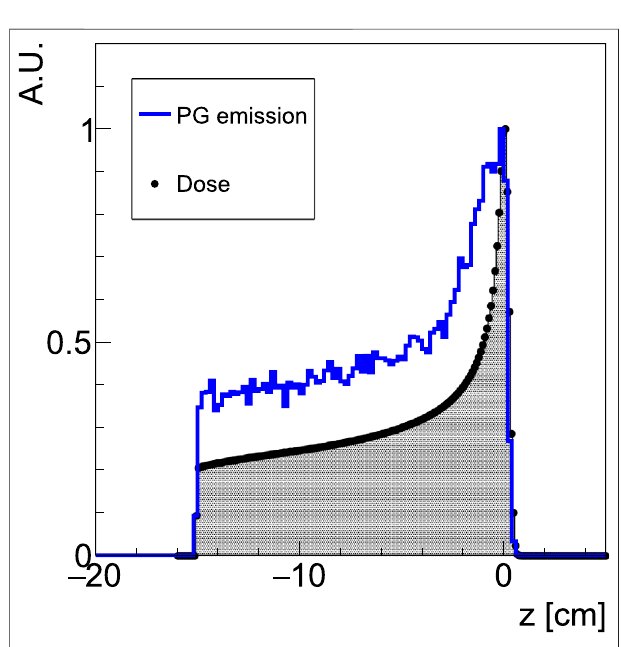
FIGURE7| 160 MeVprotonbeamdosedeposition(fulldots;blackarea) within the PMMA target, superimposed to the prompt photons (selected requiring production energy larger than 4 MeV) spatial emission distribution along the beam axis (solid blue line; white area). Each distribution is normalized to its maximum value. The PMMA entrance face is at z (cid:3) − 15.05